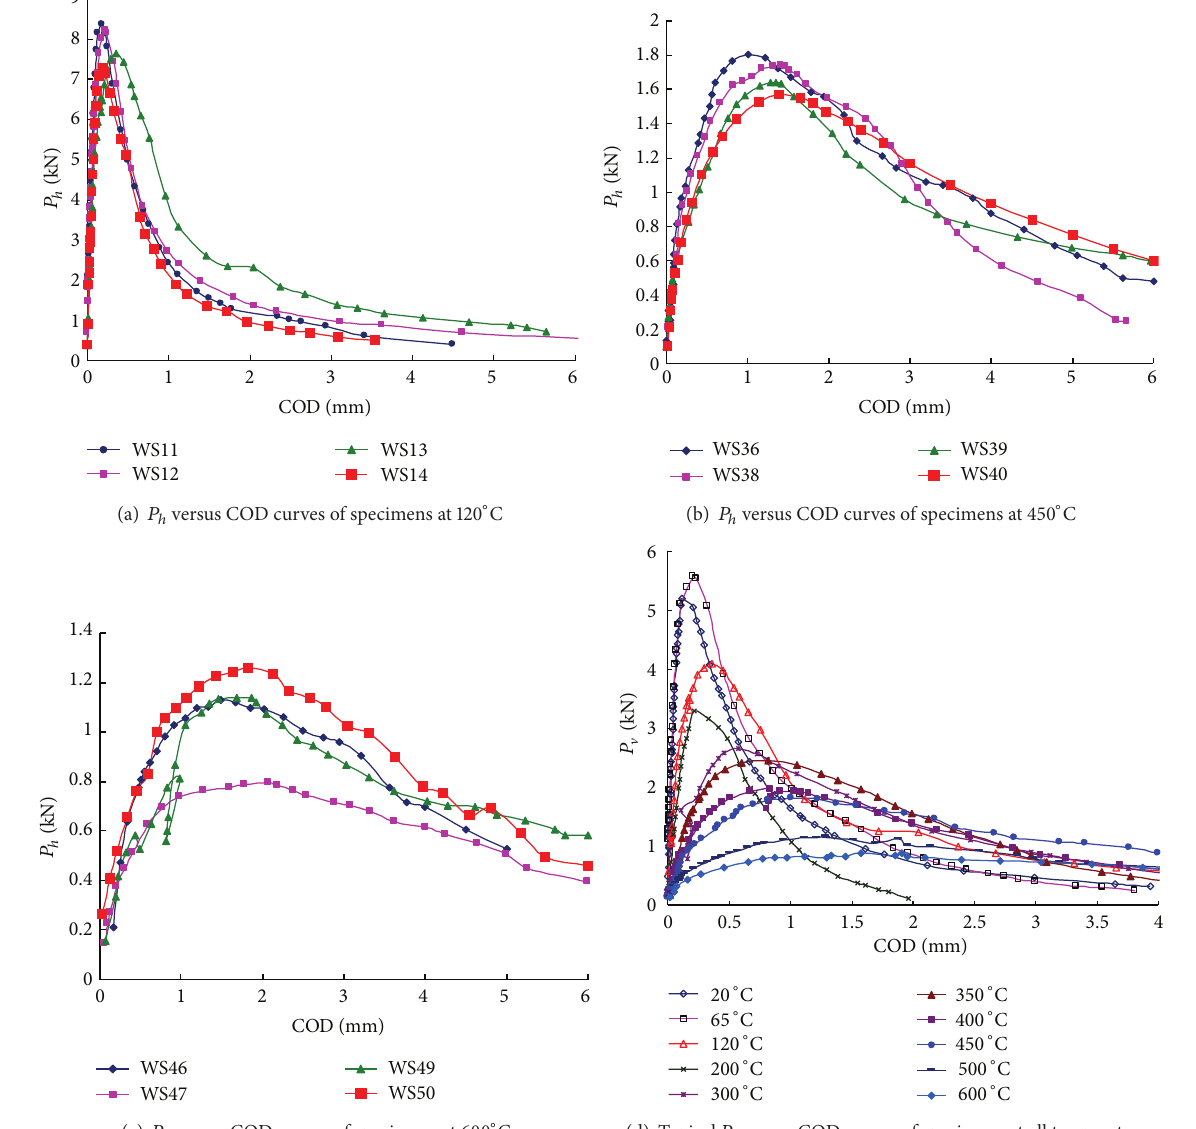
Figure 6: 𝑃 versus CMOD curves of specimens with